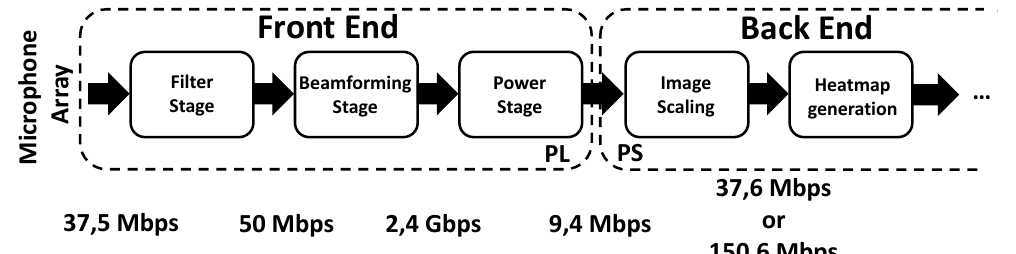
Figure 2. Bandwidth demanded by the first stages of the M3-AC